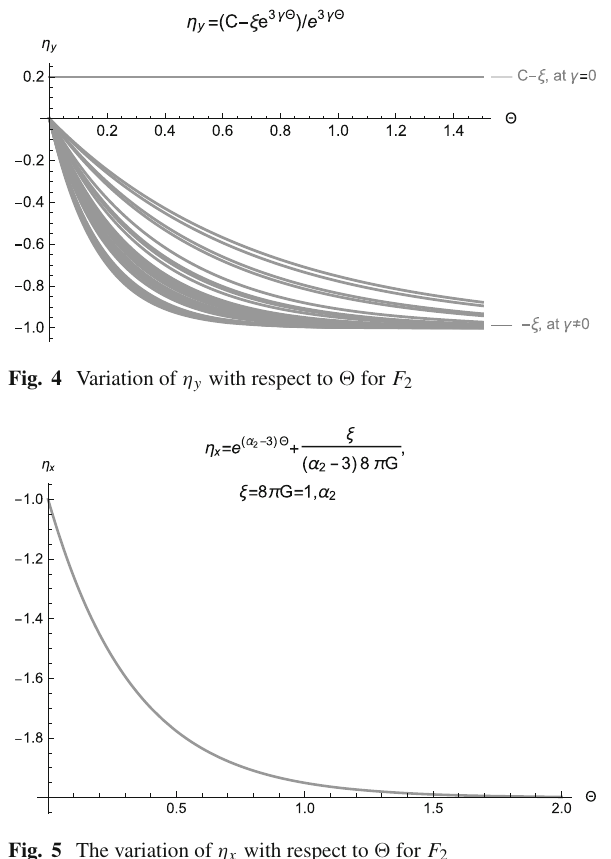
(cid:2) o + α 2 and 3 3 ( 8 π G ) 2 x